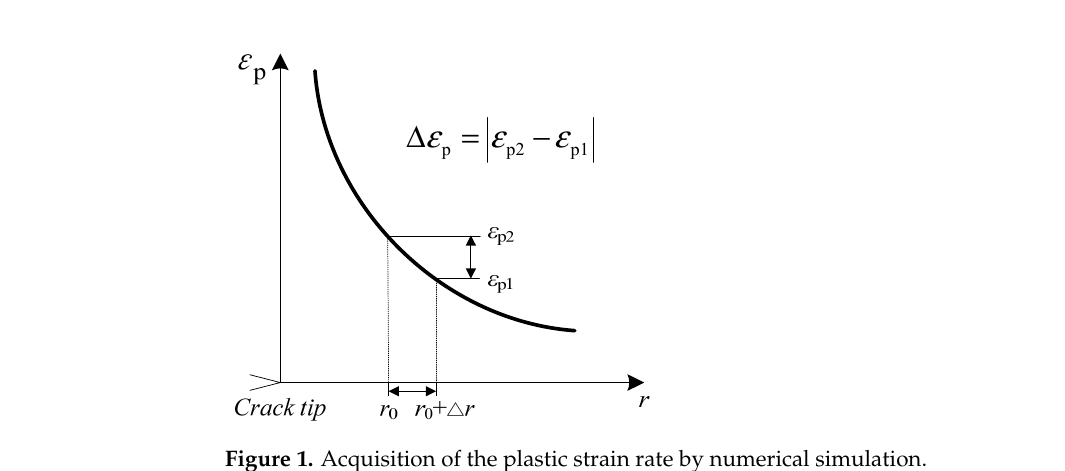
Figure 1. Acquisition of the plastic strain rate by numerical simulation.